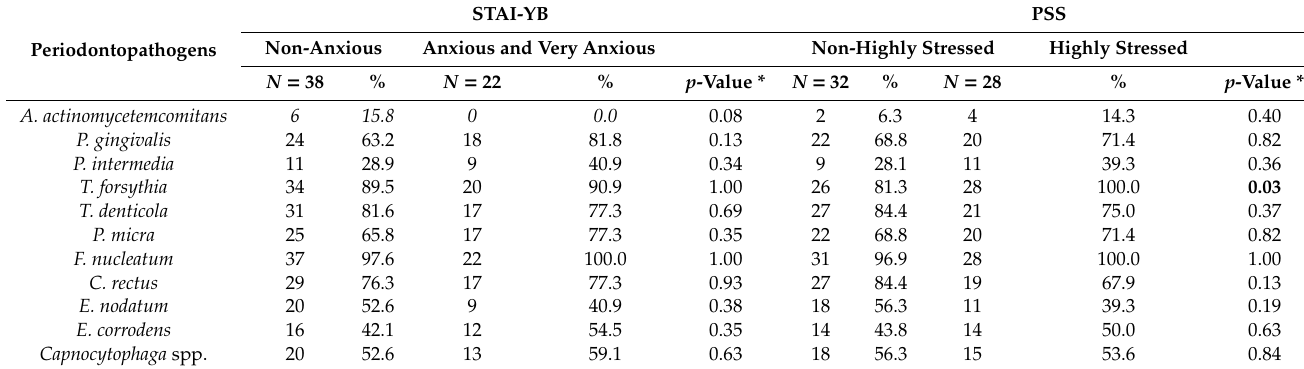
Table 5. Bacterial environment according to the psychosocial context in pathological samples from diseased patients before periodontal treatment.